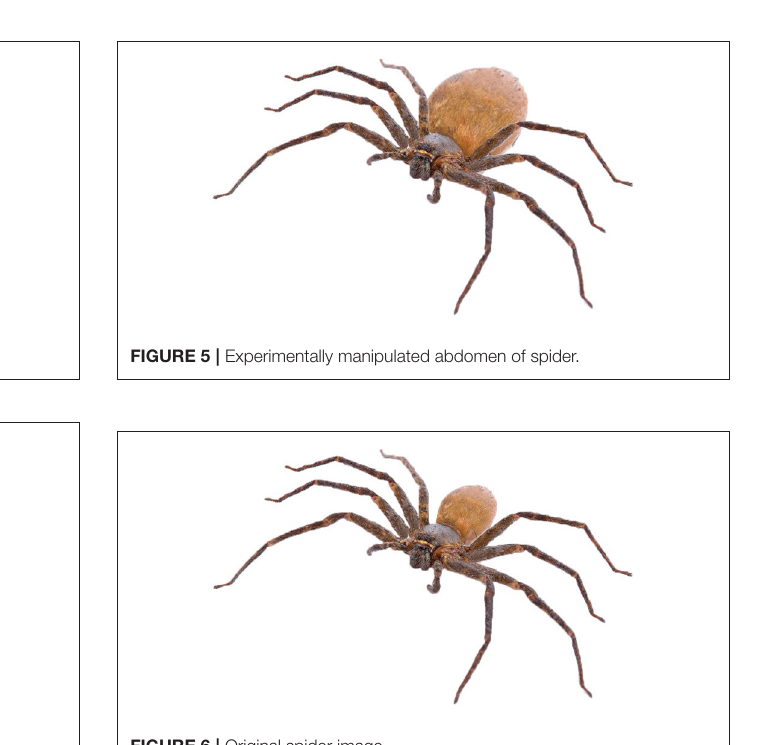
FIGURE 6 | Original spider